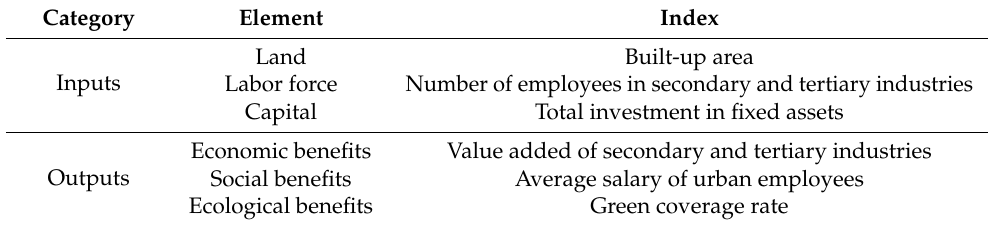
Table 3. Land-use efficiency evaluation index